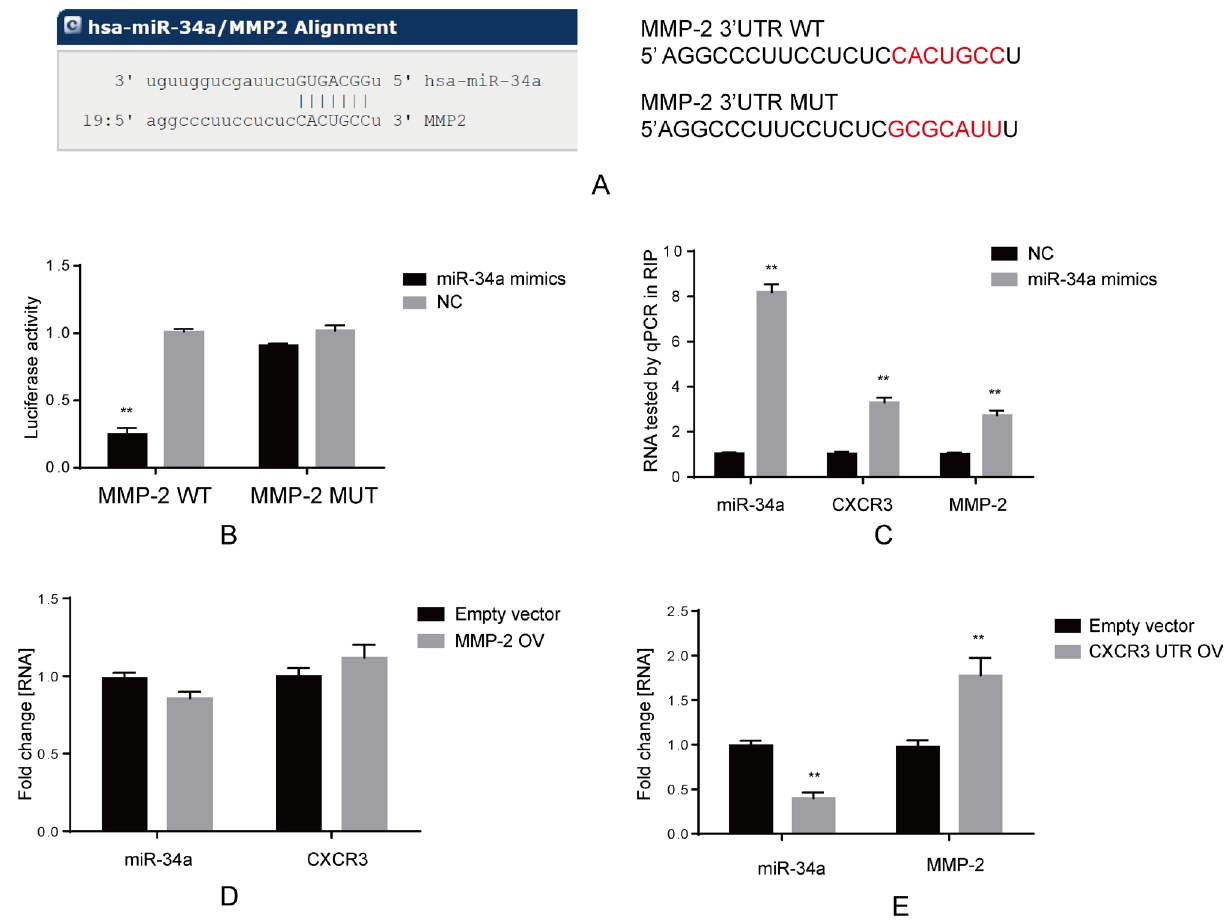
Figure 6 – Interactions confirmed among CXCR3, miR-34a and MMP-2. (A) Online prediction software was used to find potential target between MMP-2 and miR-34a (left), and seed sequence was mutated in MMP-2 3’UTR (right). (B) Luciferase assay was used to identify direct target between MMP-2 and miR-34a, the target sequence was mutated and cloned into luciferase reporter plasmid, **p < 0.01. (C) RIP assay was used to detect binding among miR-34a, MMP-2 and CXCR3. All of these three RNAs were enriched when transfected with miR-34a mimics and compared to NC group, **p < 0.01, tested by q-PCR. (D) Overexpression MMP-2 did not change the level of miR-34a and CXCR3 in VSMCs. (E) Overexpression CXCR3 3’UTR suppressed miR-34a and increased MMP-2 in VSMCs, **p < 0.01, tested by